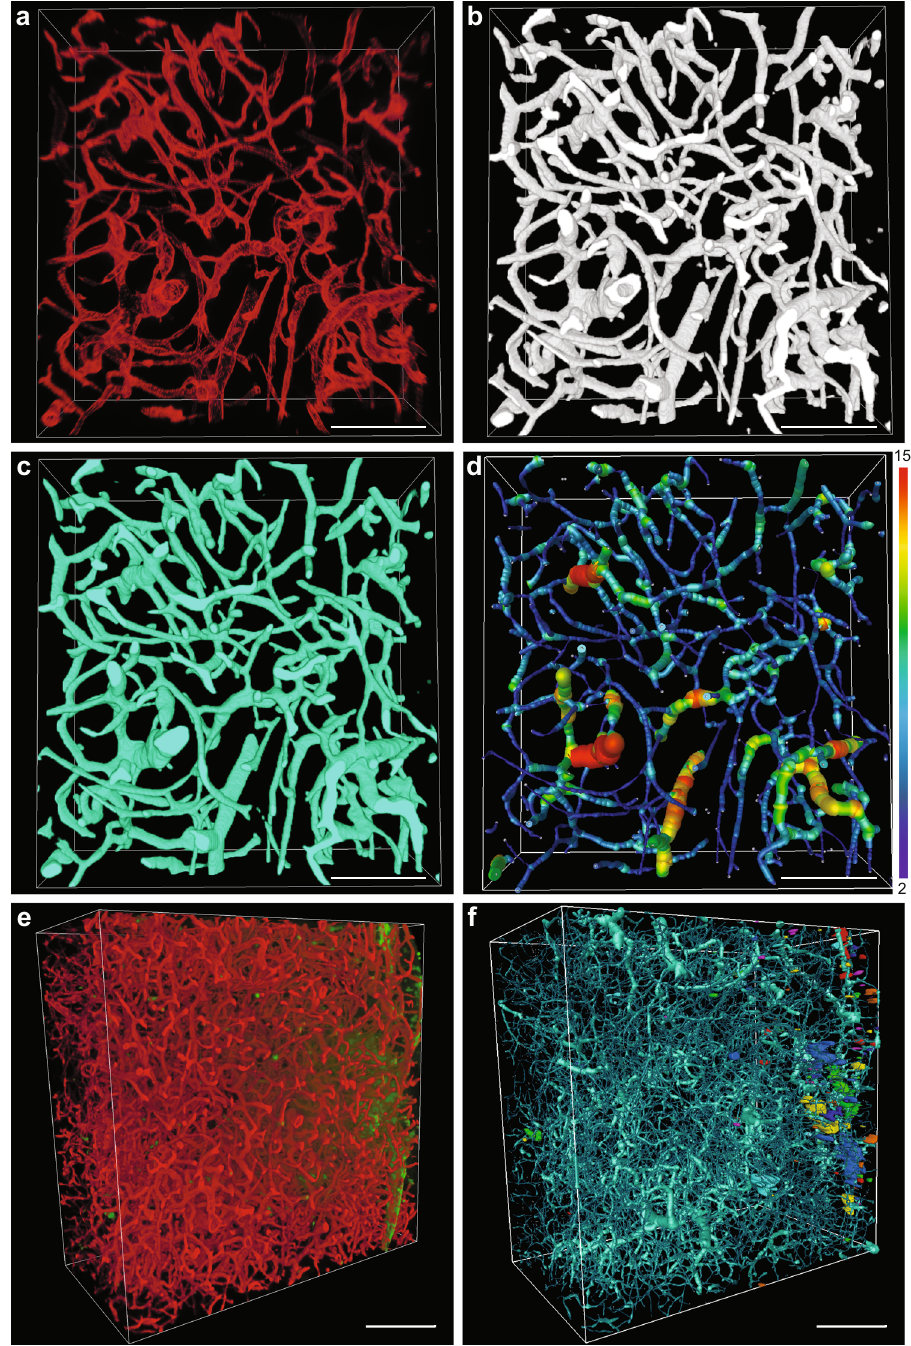
Fig. 6 A semiautomated machine learning-based work fl ow for segmentation, tracing, and analysis of GBM vasculature in 3D deep images. a 3D rendering of AF647-lectin-labeled tumor vasculature. b 3D rendering of vessel segmentation performed on the dataset in a . c 3D rendering of segmented vessels after postprocessing steps. d 3D rendering of traced GBM vasculature with color-coding according to the vessel diameter, numbers for minimum and maximum vessel diameter are presented in µ m. Scale bars, 100 µ m. e 3D rendering of AF647-lectin-labeled GBM vasculature (red) with extravasation of TRITC-dextran (green). f Dataset from e with the extravasation spots recognized (colored independently of any attributes) and the vasculature traced. Scale bars, 200 µ